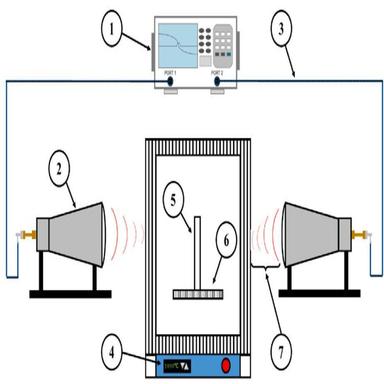
Experimental schematic setup for high-temperature dielectric property measurement of ceramic samples from RT to 1000 ◦C over the Ka-band. Equipment: (1) two port network analyzer (2) spot-focusing lens antenna (3) coaxial cable (4) adjustable high-temperature box furnace (5) ceramic test sample (6) zirconia sample holder (7) high-frequency electromagnetic waves.